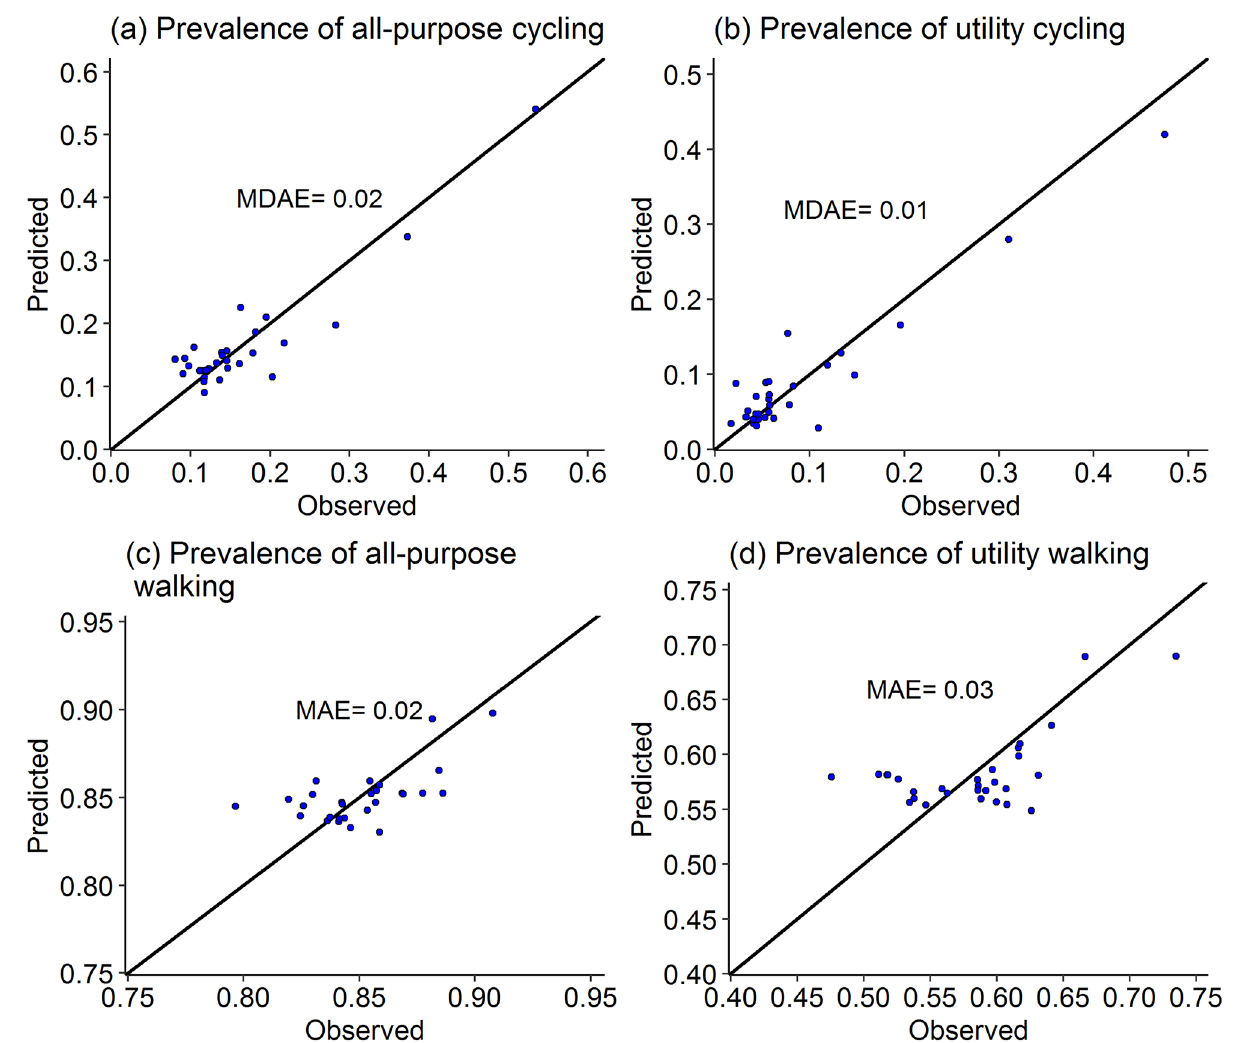
Fig 6. Observed and predicted prevalence measures using LOOCV with mean absolute error (MAE) and median absolute error (MDAE) for cycling measures (a: Model 5; b: Model 6; c: Model 7; d: Model